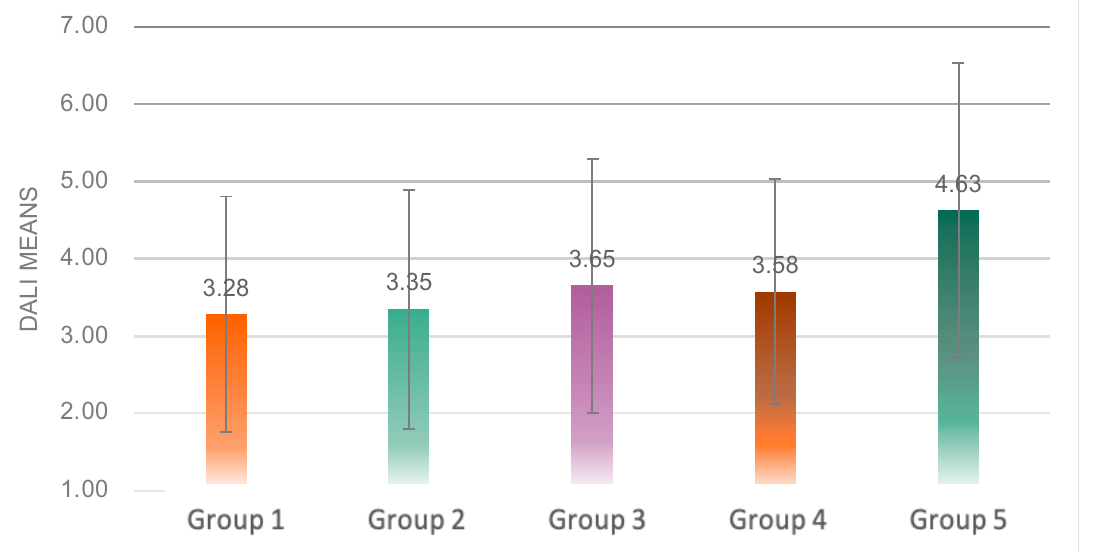
Figure 15. Detail values of the DALI scale of the five groups. In terms of interference, Group 5 was significantly higher than all other experimental groups; in situational stress, dimension Group 5 was significantly higher than Group 2 ( p = 0.040 < 0.05). This indicates that the speech rate of Group 5 makes the driver’s workload increase. The normal speech rate of Group 1 and Group 2 was able to reduce the workload of the subjects, mainly due to the reduction of attentional demands, especially visual de- mands.